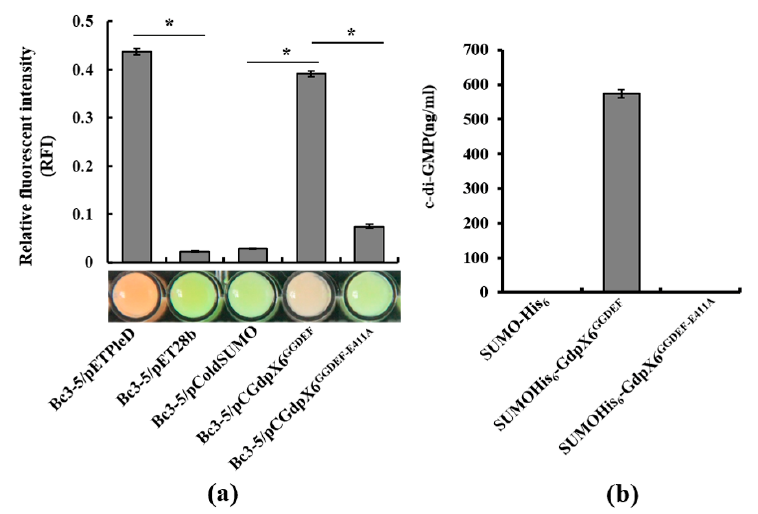
Figure 2. Analysis of diguanylate cyclase (DGC) activity of GdpX6. ( a ) Verification of the DGC activity of GdpX6 in E. coli BL21(DE3) using riboswitch (Bc3 ‐ 5 RNA) based dual ‐ fluorescence system. All bacteria strains were induced with 1 mM IPTG at 28 °C for 20 h. Visible fluorescence of bacterial suspensions was photographed. The relative fluorescence intensity (RFI) is calculated as the ratio of fluorescence intensity at 489 nm to fluorescence intensity at 547 nm. ( b ) The DGC activity of GdpX6 was detected by LC ‐ MS ‐ MS. Purified proteins were incubated with 100 μ M of GTP overnight. HPLC was carried out to analyze the products. Three independent experiments were carried out with similar results. * indicates P < 0.05 as determined by t ‐ test